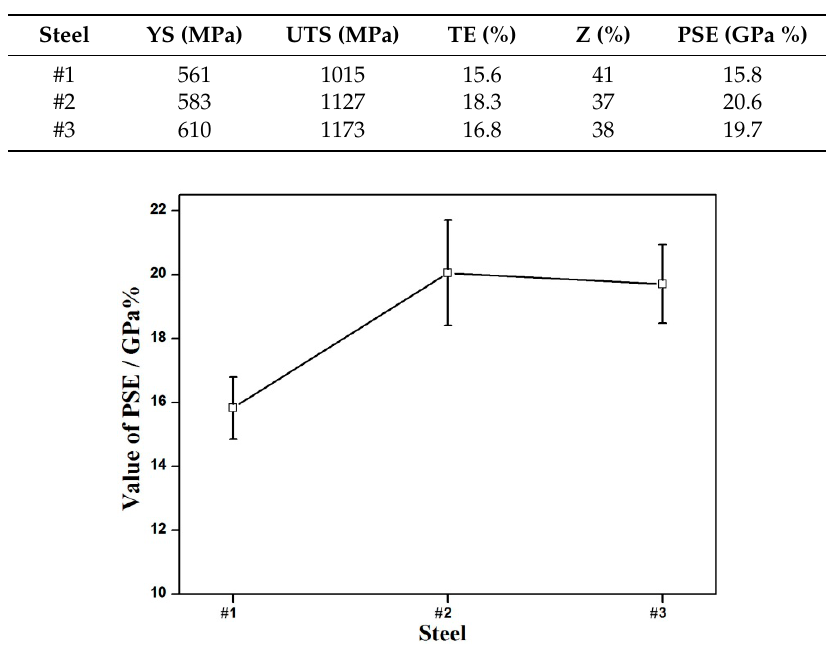
Figure 4. The product of strength and elongation (PSE) in steels with different Mo contents.